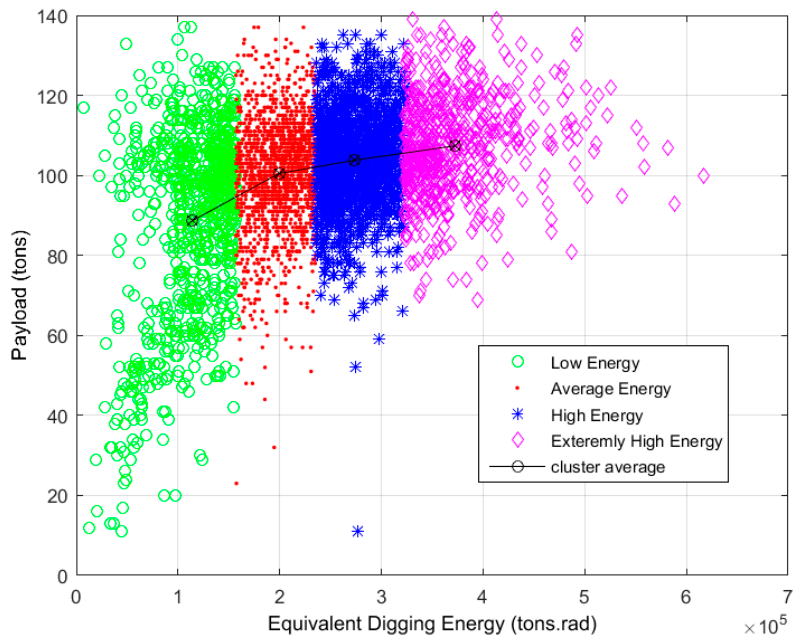
Figure 5. Result of clustering analysis for comparison of payload and equivalent digging energy.